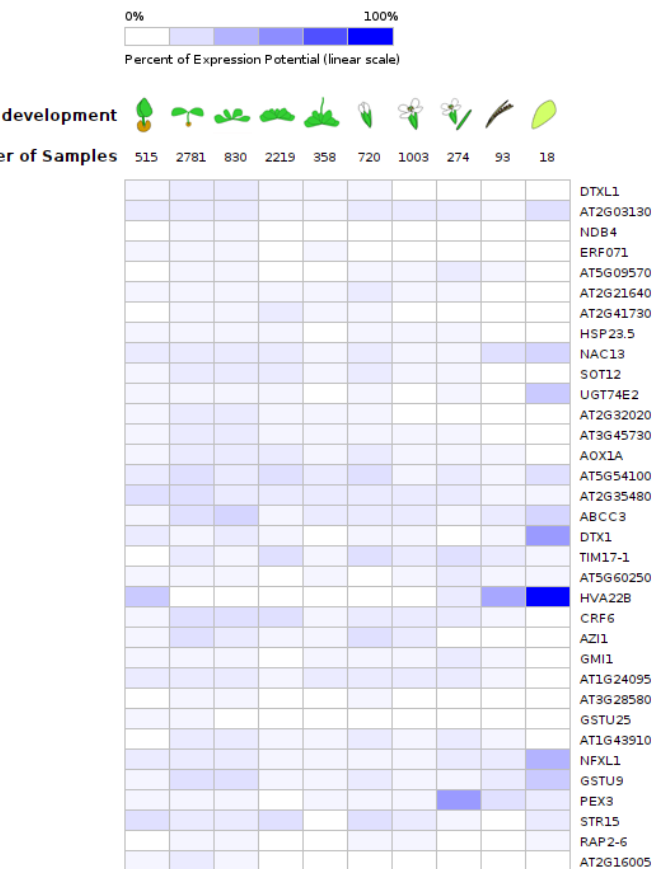
Figure 12. Developmental expression pattern analysis of a common set of genes that were differen- tially expressed in the transcriptome of ailanthone-treated Col-0, Cvi-0, and U112-3 samples using the Genevestigator database (accessed on 12 September 2022) (https://genevestigator.com/gv/). Because ailanthone-treated plants showed a strong inhibition of primary root growth and excessive accumulation of ROS, we analyzed the expression of the 34 common genes